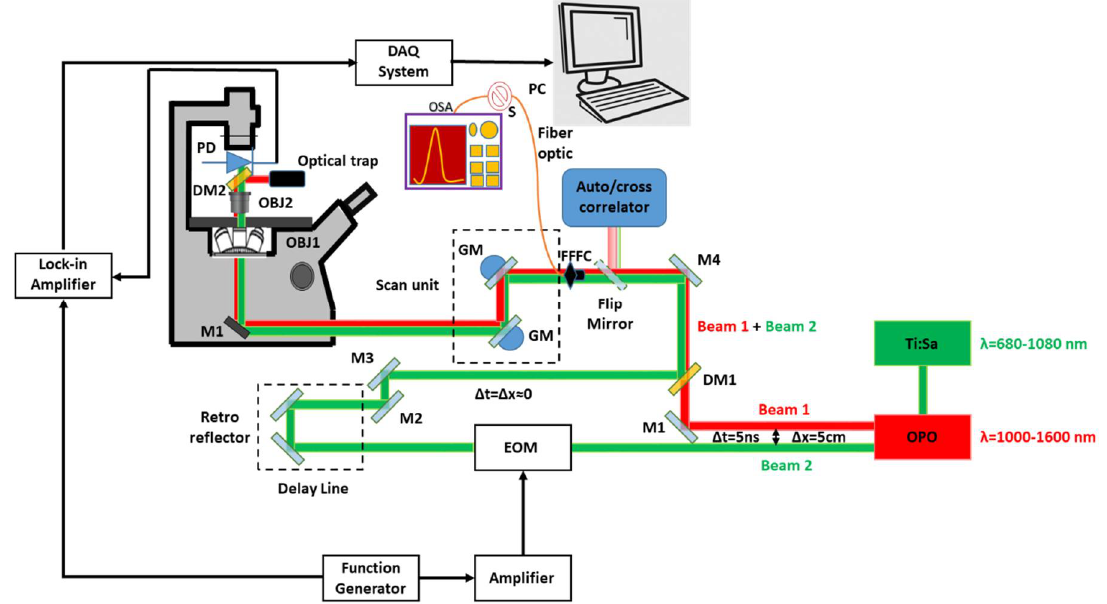
Figure 3. Experimental setup for stimulated Raman scattering imaging. (Ti:Sa): Titanium-Sapphire pulsed laser source; OPO: optical parameter oscillator; M: mirror; EOM: electro-optical modulator; GM: galvo-mirror; DM: dichroic mirror; OBJ: objective lens; PD: photo-detector; FFFC: flip flop fiber coupler; S: multimode optical fiber; OSA: optical spectrum analyzer.